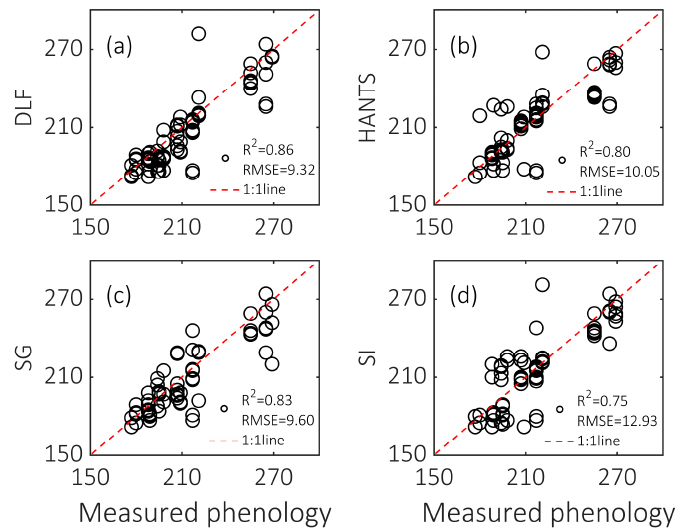
Figure 5. The comparison of extracted and observed phenology from ground observations using different filtering methods. Note: ( a – d ) represented the comparison of extracted phenology using DLF, HANTS, SG, and SI, respectively.